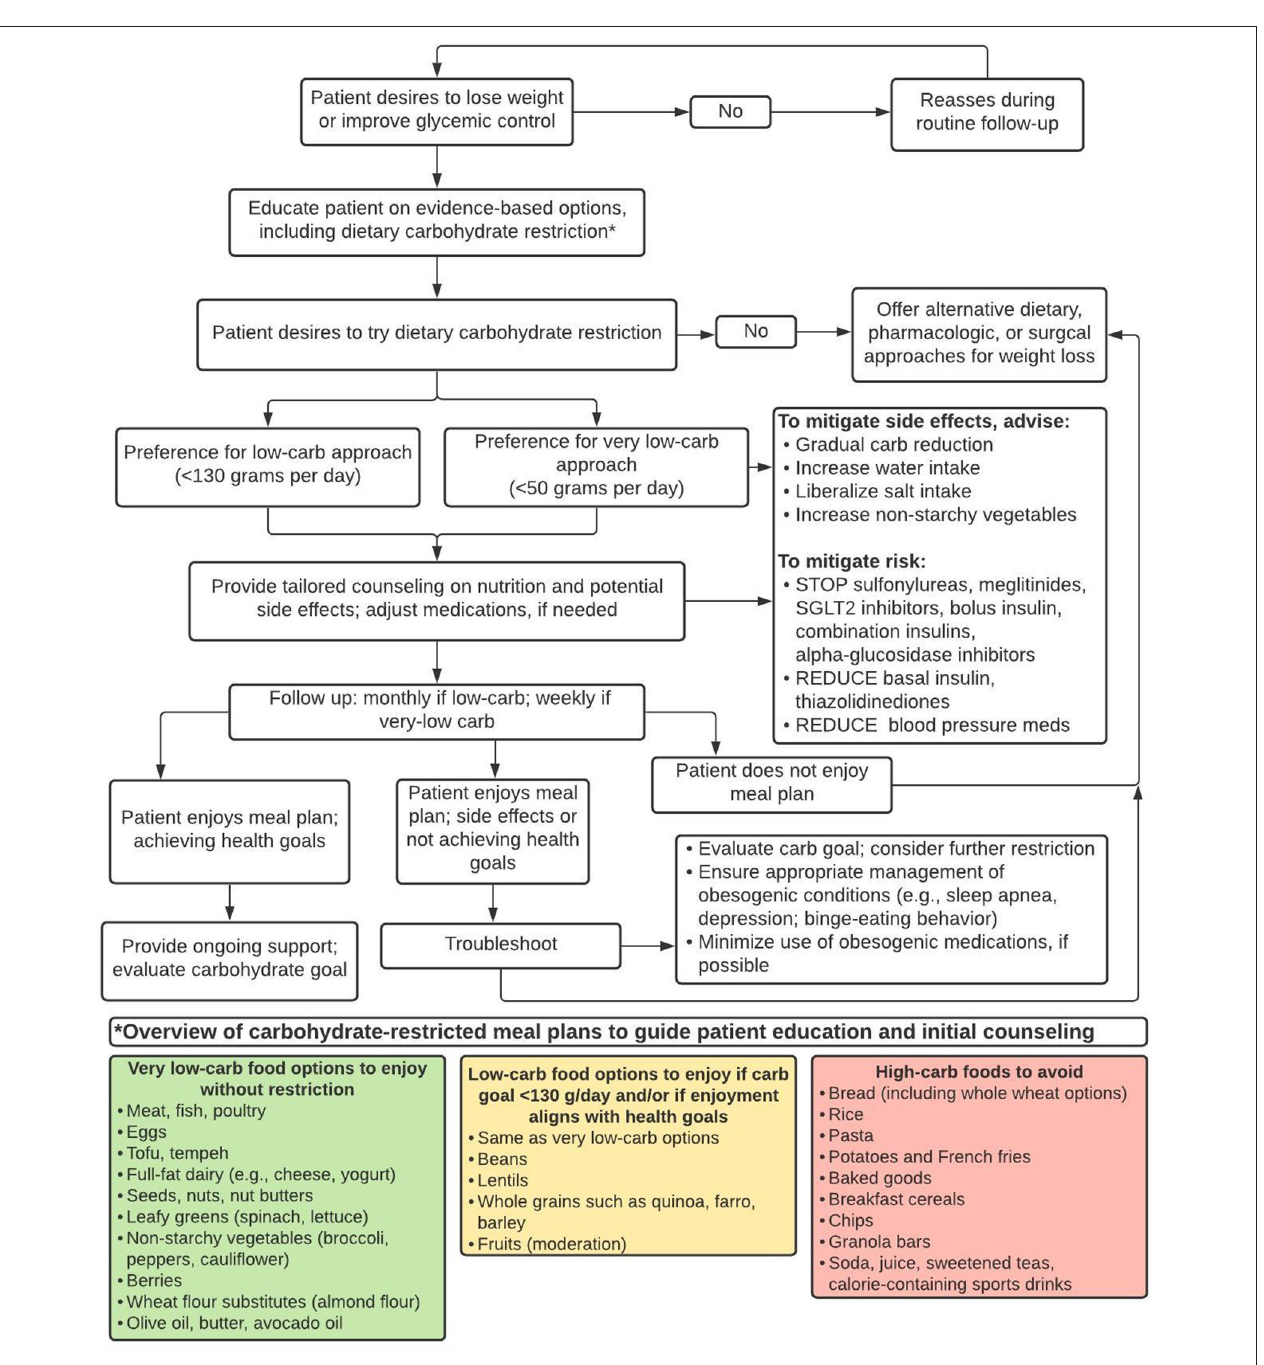
FIGURE 1 | A pragmatic approach to identify and support patients with obesity and/or type 2 diabetes who may prefer and benefit from dietary carbohydrate restriction for weight loss and/or glycemic control.